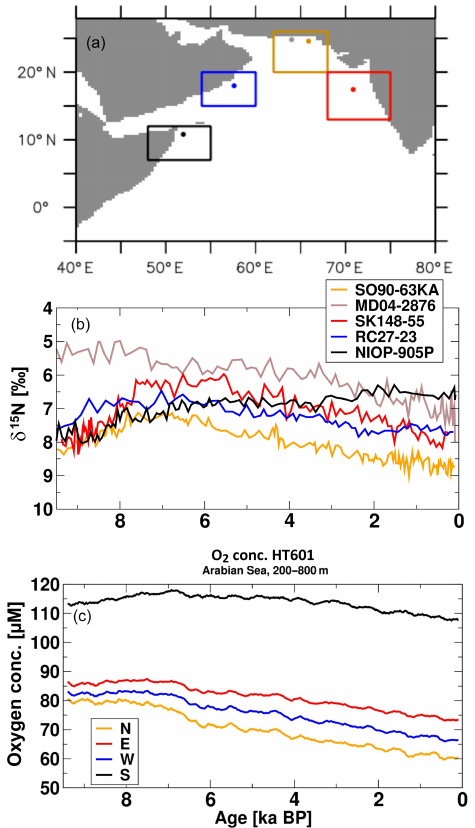
Figure 9. (a) Locations of high-resolution cores (circles) and areas of model simulations (boxes). (b) Increasing δ 15 N values in high- resolution cores from the Arabian Sea (note inverted scale) show increasing denitrification since about 6000–8000BP; data from the northern (yellow; light brown), eastern (red), western (blue), and southwestern (black) Arabian Sea. Sediment cores: SO90-63KA (Burdanowitz et al., 2019), RC27-23 (Altabet et al., 2002), NIOP- 905P (Ivanochko et al., 2005), SK148-55 (Kessarkar et al., 2018), and MD04-2876 (Pichevin et al., 2007) parallel with (c) sinking oxygen concentrations in biogeochemical model simulations driven by the Kiel Climate Model/PISCES model in the northern (yellow), eastern (red), western (blue), and southern Arabian Sea (dark grey). See text for definition of regions. Model results are 20-year running